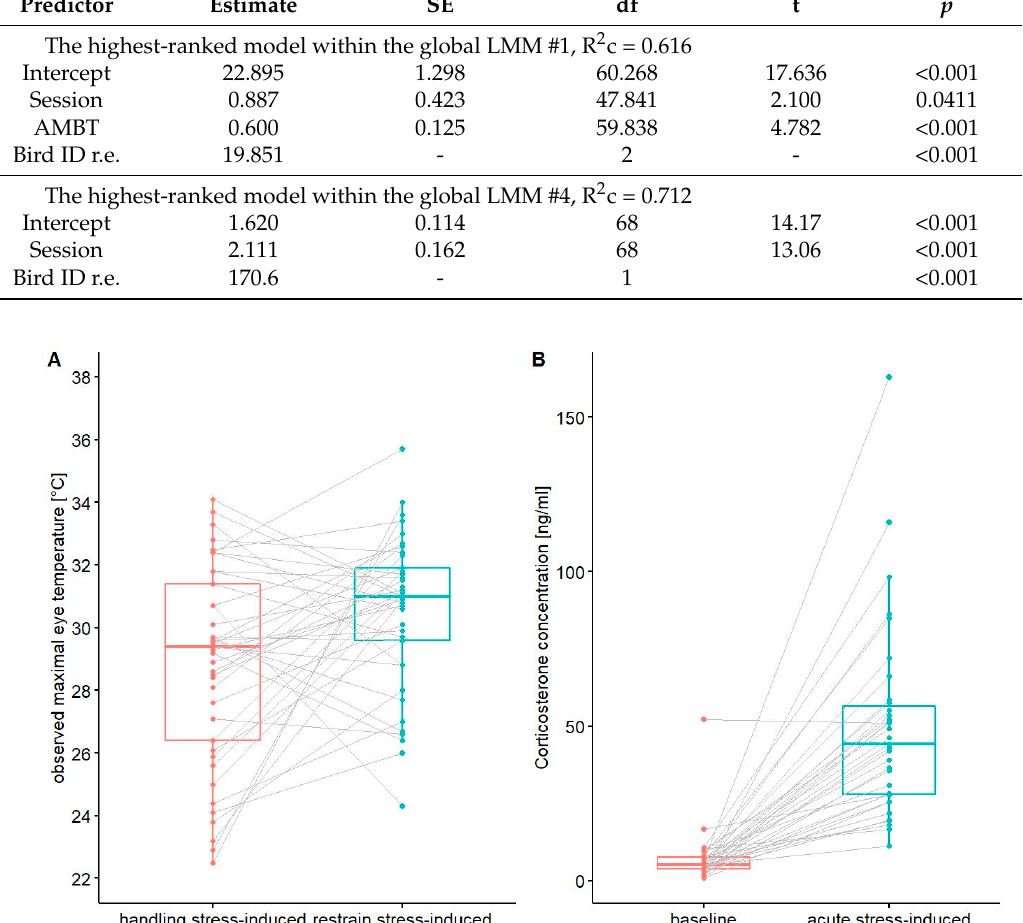
Figure 2. Comparison of maximal eye temperature of Little Auks between the first session (handling stress-induced; in red) and second session (restrain stress-induced; in blue) of the capture-restraint procedure ( A ) and corticosterone concentration in blood of Little Auks between the first session representing corticosterone baseline level and the second one representing the acute stress-induced level ( B ). Boxplots show the median (band inside the box), the first (25%) and third (75%) quartile (box), the lowest and the highest values within 1.5 interquartile range (whiskers), and outliers (dots); lines connect values recorded in the same individuals.